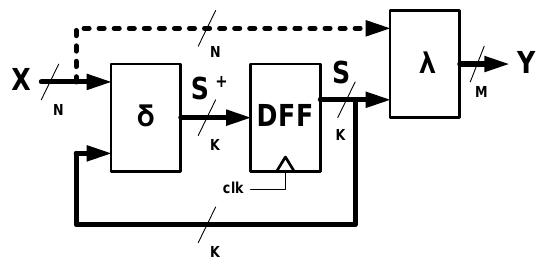
Figure 1. The block scheme of FSM (finite state machine).